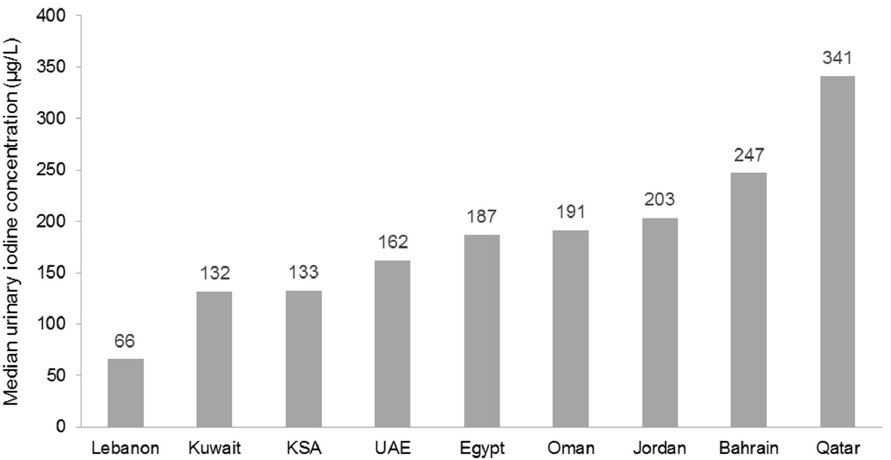
Figure 4. Urinary iodine concentrations in the 2015 Iodine Global Network Scorecard [118].